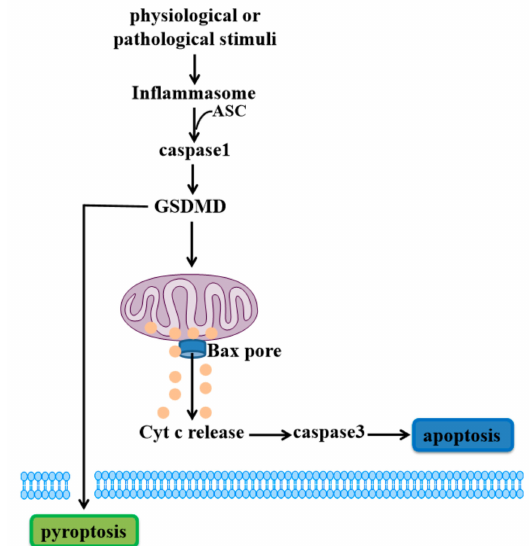
Figure 1. Gasdermin D (GSDMD)-mediated cell death. When physiological or pathological stimuli activates inflammasomes, ASC is recruited to lead to activation of caspase1. GSDMD is cleaved by caspase1 to release active GSDMD-N, translocating to the plasma membrane to induce pyroptosis. Meanwhile, GSDMD-N can also permeabilize the mitochondrial membrane to trigger the mitochondrial apoptotic pathway downstream of inflammasome activation, inducing cell